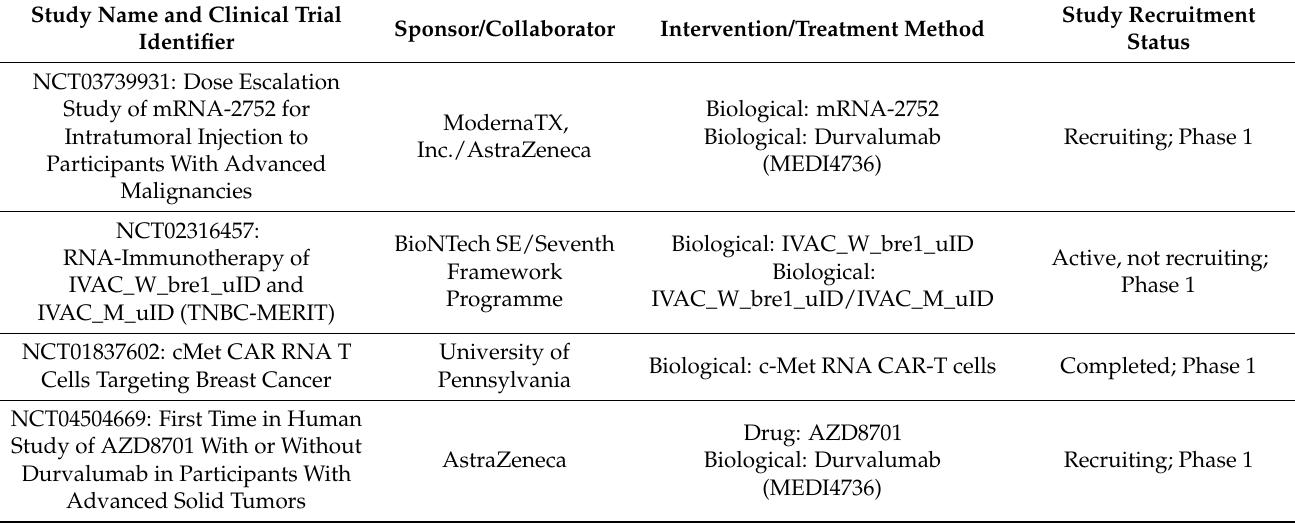
Table 4. Clinical studies using RNA-based therapeutics for targeted treatment of TNBC (reference: clinicaltrials.gov, 11 October